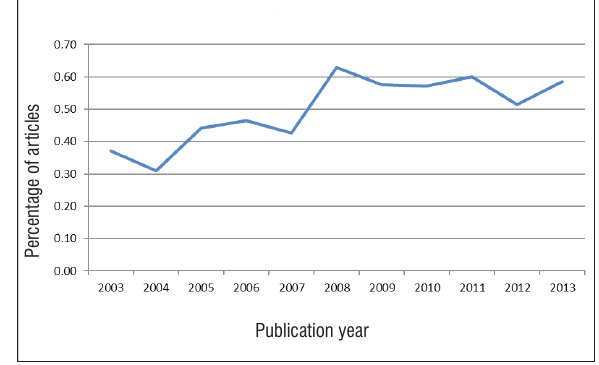
Figure 3: Percentage of energy-related articles from South Africa relative to the total number of articles in the field during the period